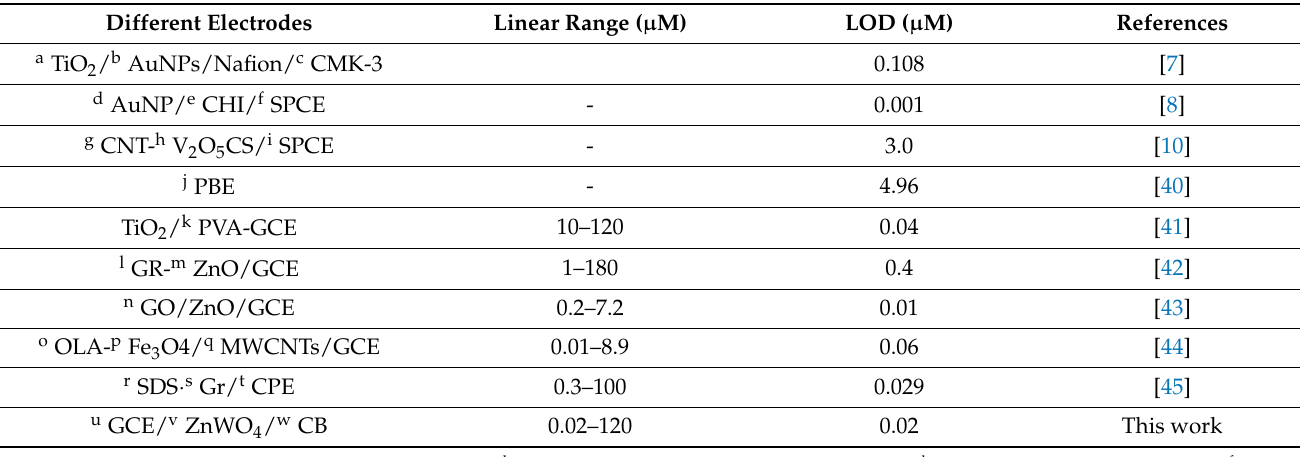
Table 1. Comparison by modified GCE/ZnWO 4 /CB electrode with different sensors in CIP detection. Different Electrodes Linear Range ( µ M) LOD ( µ M)